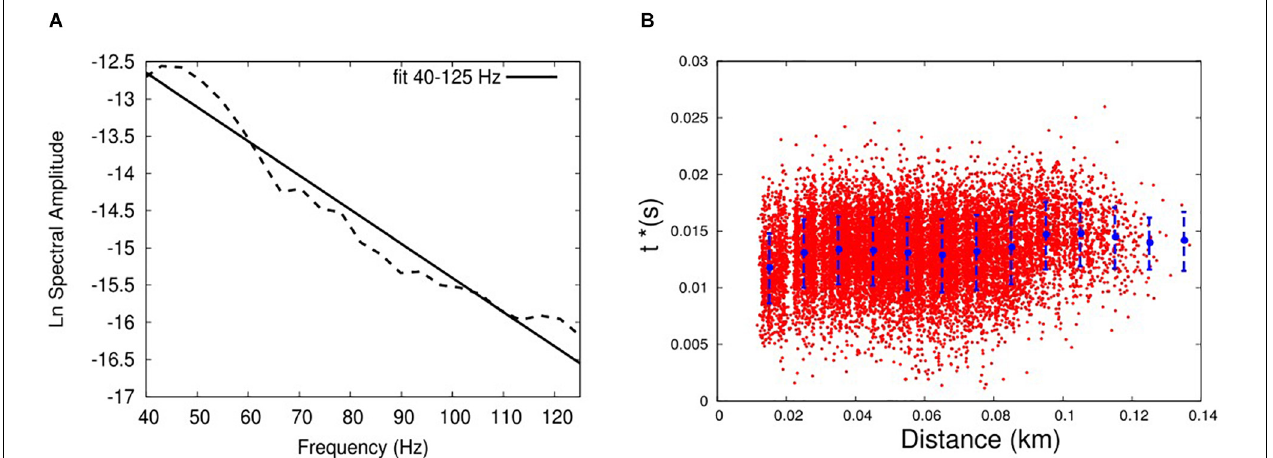
FIGURE 4 | (A) Example of a displacement spectrum (dashed line) fitted in the least-squares sense in the frequency range 40–125 Hz. (B) final t ∗ dataset, with average values (blue points), with standard deviation associated (dashed blue lines) computed in interval of distances of 10